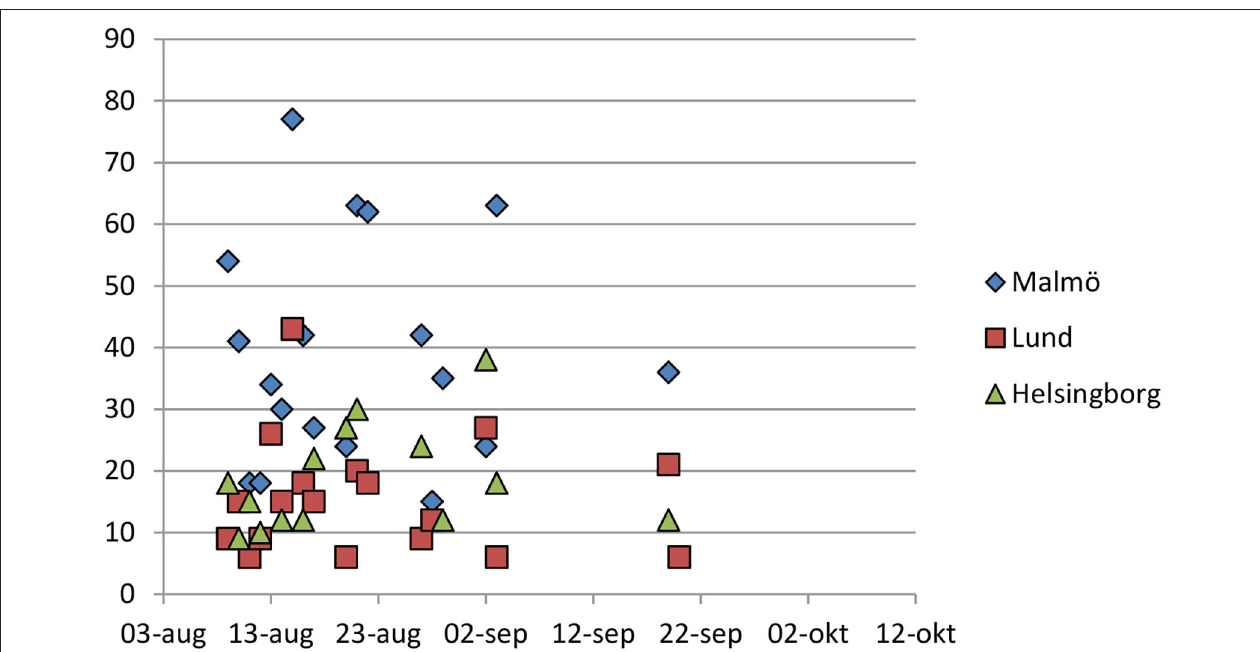
FIGURE 5 | Actual time spent for the helicopter at the three treatment cities per day.